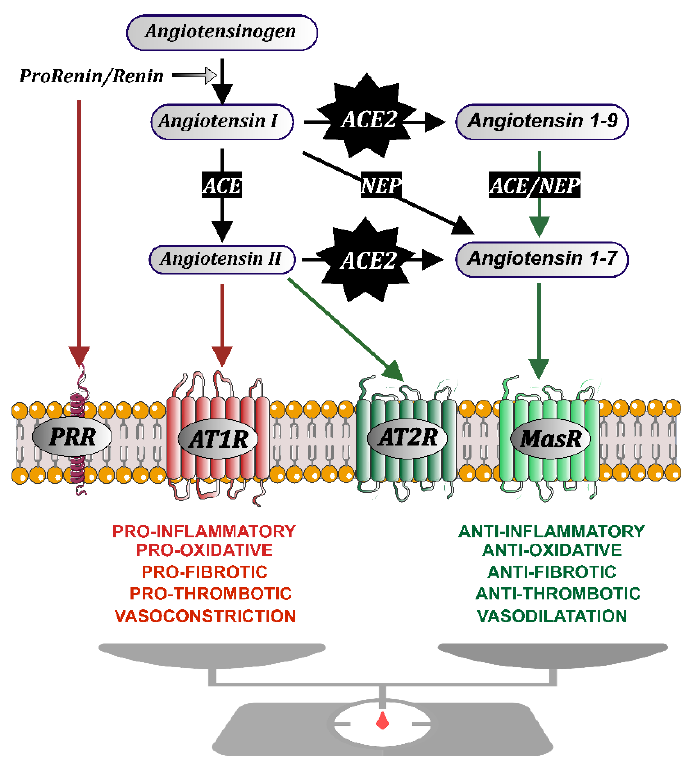
Figure 1. The renin-angiotensin system (RAS) consists of two axes that counteract each other: a pro- inflammatory axis (red arrows) mainly constituted by Angiotensin II acting on AT1 receptors (AT1R), and an anti-inflammatory axis (green arrows) constituted by Angiotensin II acting on AT2 receptors, and particularly Angiotensin 1-7 acting on Mas receptors. Angiotensin II is produced by the action the enzyme prorenin/renin on the precursor protein angiotensinogen, producing Angiotensin I, which is transformed by the angiotensin-converting enzyme (ACE) into Angiotensin II. Renin and its precursor prorenin (PR) can also activate specific PR receptors. Angiotensin-converting enzyme 2 (ACE2) plays a central role in the RAS balance, as ACE2 (with the aid of peptidases such as Neprilysin, NE) con- verts compounds of the pro-inflammatory arm (Angiotensin I and, particularly, Angiotensin II) into compounds of the anti-inflammatory arm (i.e., Angiotensin 1-9 and, particularly Angiotensin 1-7).